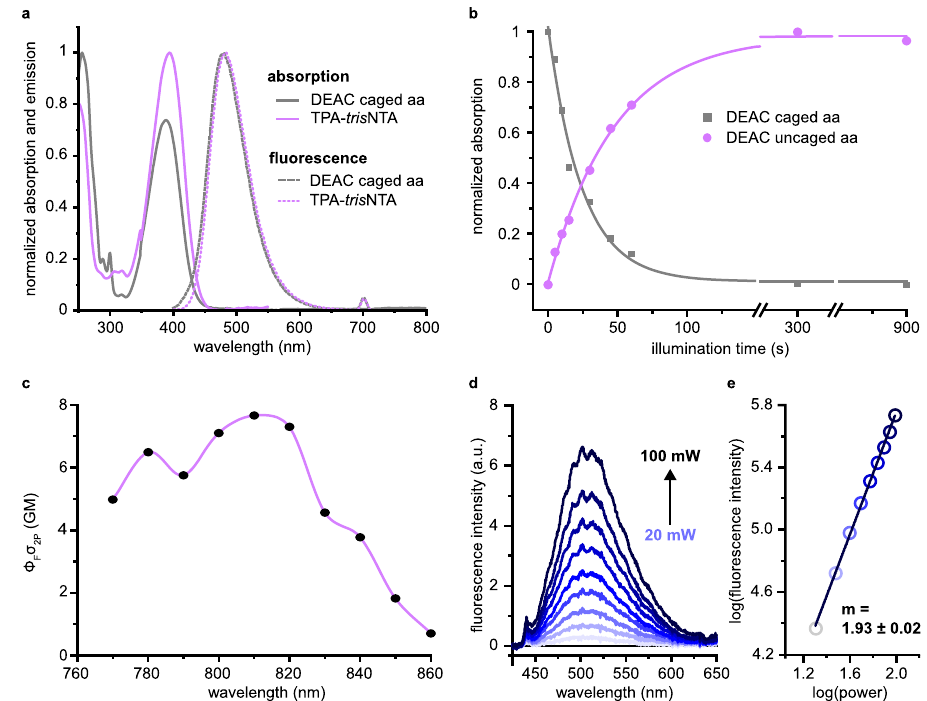
Fig. 2 Photophysical properties of TPA- tris NTA. a Normalized absorption and fl uorescence spectra of DEAC β -amino acid and TPA- tris NTA in HBS buffer/MeCN (1:1, v/v). b Quanti fi cation of photoscission showed the disappearance of DEAC β -amino acid and formation of the uncaged product as a function of illumination time at 405 nm. c Two-photon absorption cross section values of GM ( ϕ F Ϭ 2P ) for TPA- tris NTA determined by two-photon excited fl uorescence measurement and referenced to values of coumarin 307. d Power-dependent fl uorescence spectra upon two-photon excitation of TPA- tris NTA at an excitation wavelength of 800 nm. e Intensities of the power dependent fl uorescence spectra of TPA- tris NTA were logarithmically plotted against the logarithm of the power. The parameter for two-photon power dependency was found to be 1.93 ± 0.02, con fi rming a two-photon process for TPA- tris NTA activation at 800